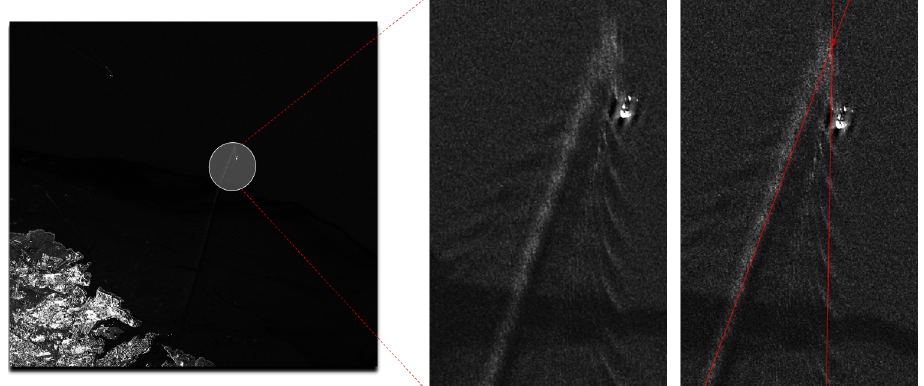
Figure 4. Wake pattern detection. (COSMO-SkyMed Product— c (cid:13) ASI 2016 processed under license from ASI—Agenzia Spaziale Italiana, all rights reserved, distributed by